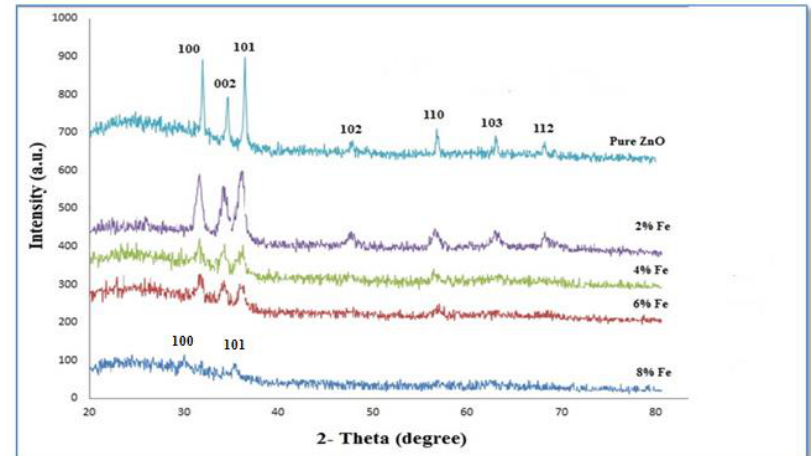
Fig. 1: XRD pattern of ZnO thin films for different doping concentrations of